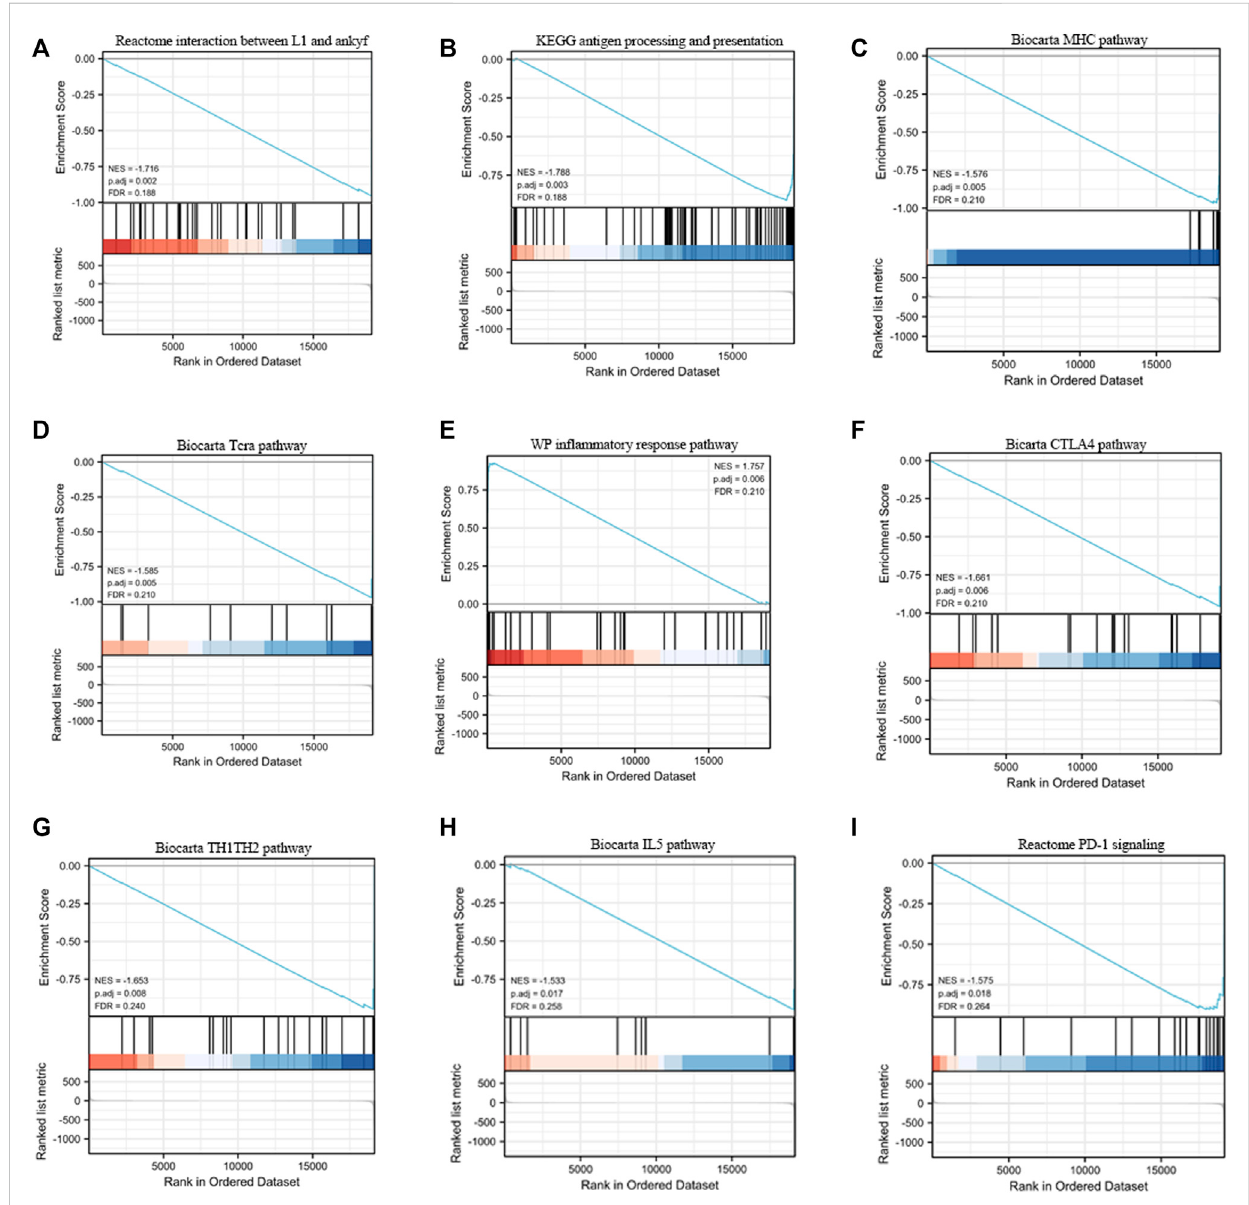
FIGURE 5 Gene set enrichment analysis (GSEA) of the ICD-related lncRNA prognostic signature. (A) Reactome interaction between L1 and ankyrins. (B) KEGG antigens and presentation. (C) Biocarta MHC pathway. (D) Biocarta TCRA pathway. (E) WB in fl ammatory response pathway. (F) Biocarta CTLA4 pathway. (G) Biocarta Th1Th2 pathway. (H) Biocarta IL5 pathway. (I) Reactome PD-1